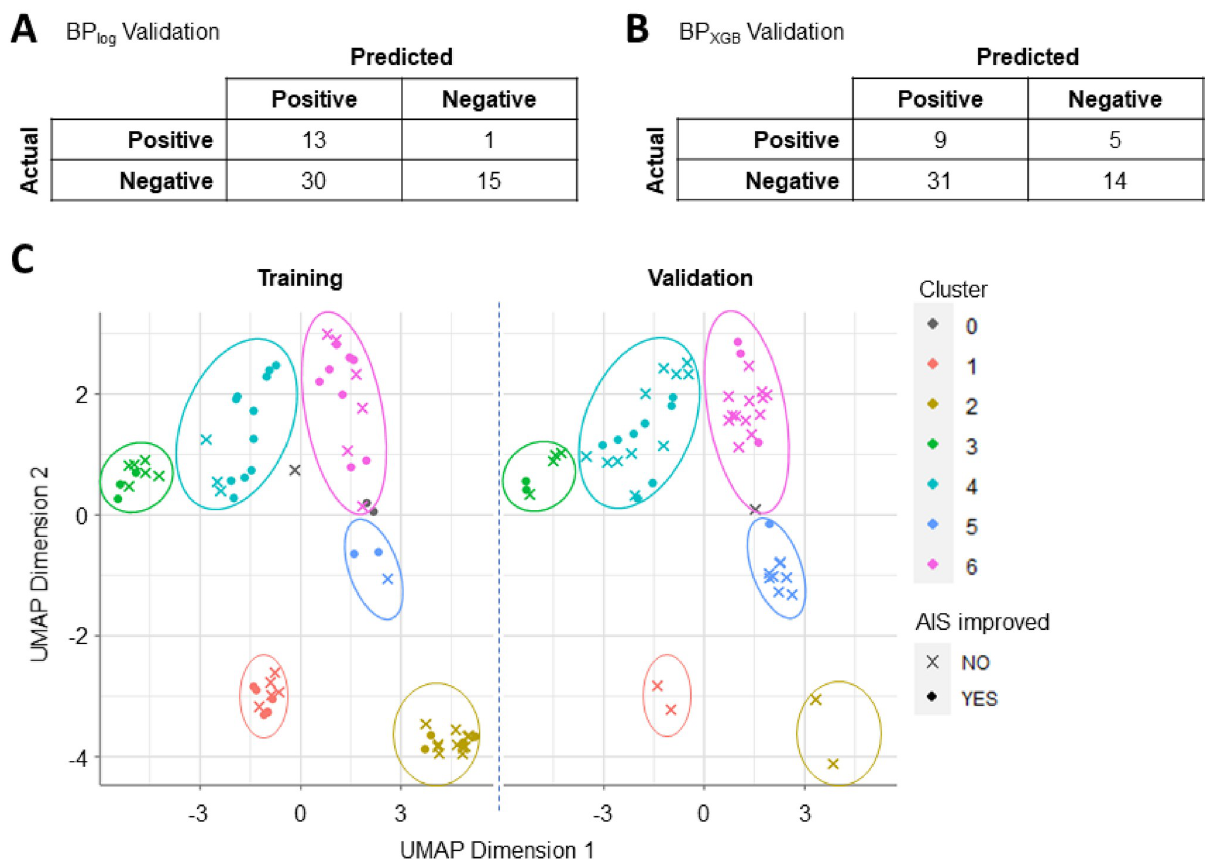
Fig 7. Model validation confusion matrices and clustering analysis to demonstrate differences in patient population between training and validation datasets. Validation predictions were scored by comparing the average predicted probability of each validation sample against the average best F1 threshold for the corresponding model. (A) The best parsimonious BP log model correctly predicted 13 of the 14 true positives (i.e. patient improved in outcome) and 15 of the 45 true negatives. (B) The best parsimonious BP XGB model correctly predicted 9 of the 14 true positives and 14 of the 45 true negatives. (C) UMAP and HDB clustering analysis on the combined training and validation data produced six clusters of patients. Notably, Clusters 1 and 2 showed high representation in the training cohort and low representation in the validation cohort. Conversely, Cluster 3 showed low and high representation in the training and validation cohorts respectively. Clusters 3, 5, and 6 have no discernable differences between cohorts.